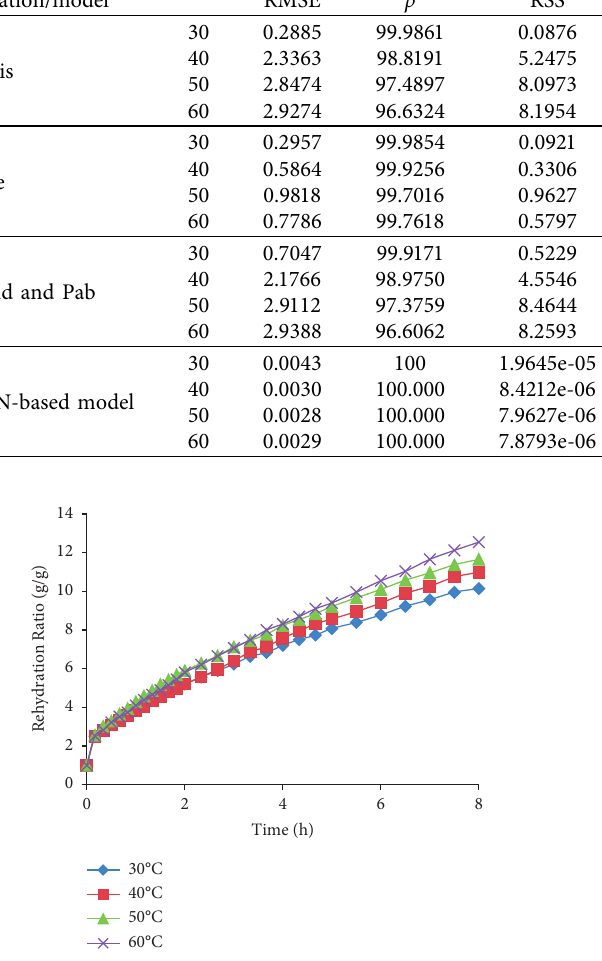
Figure 3: Rehydration ratio of sea cucumber at different drying